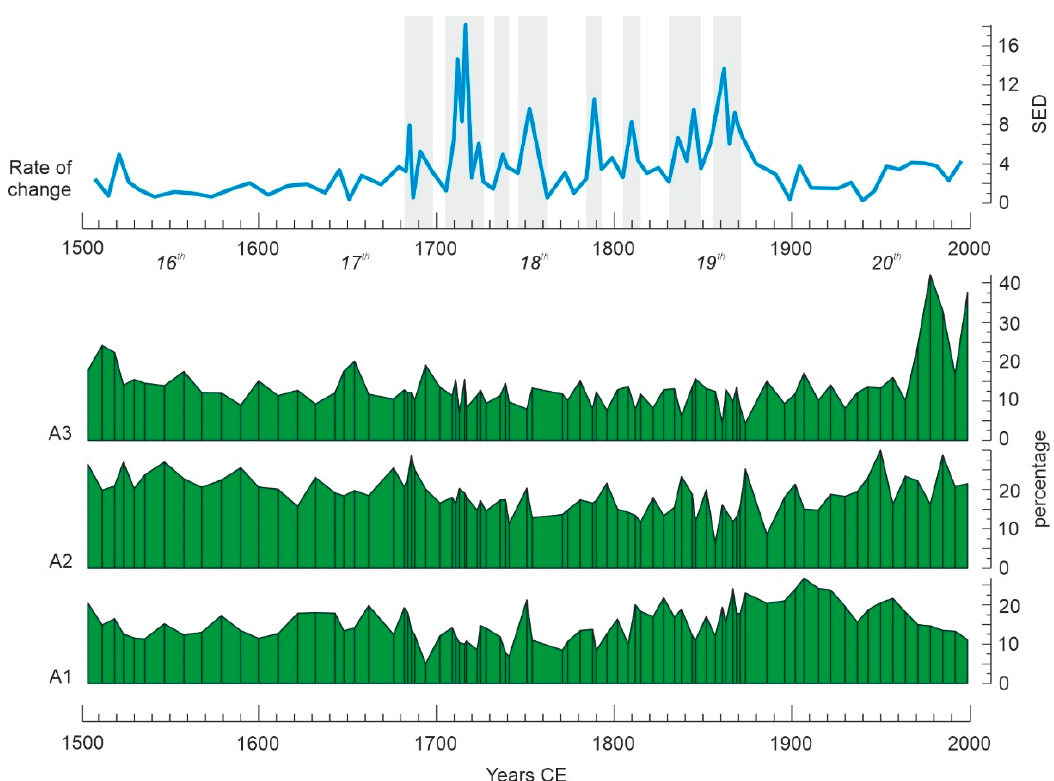
Figure 12. Cluster analysis of forest-tree pollen elements performed using the Pearson coefficient and the UPGMA clustering approach [57,58]. The dominant taxa of each forest assemblage are in